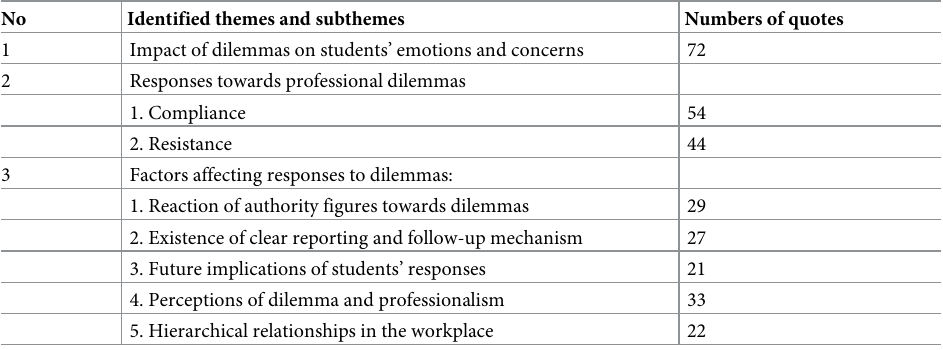
Table 1. Impact, response, and factors related to professional dilemmas in medical